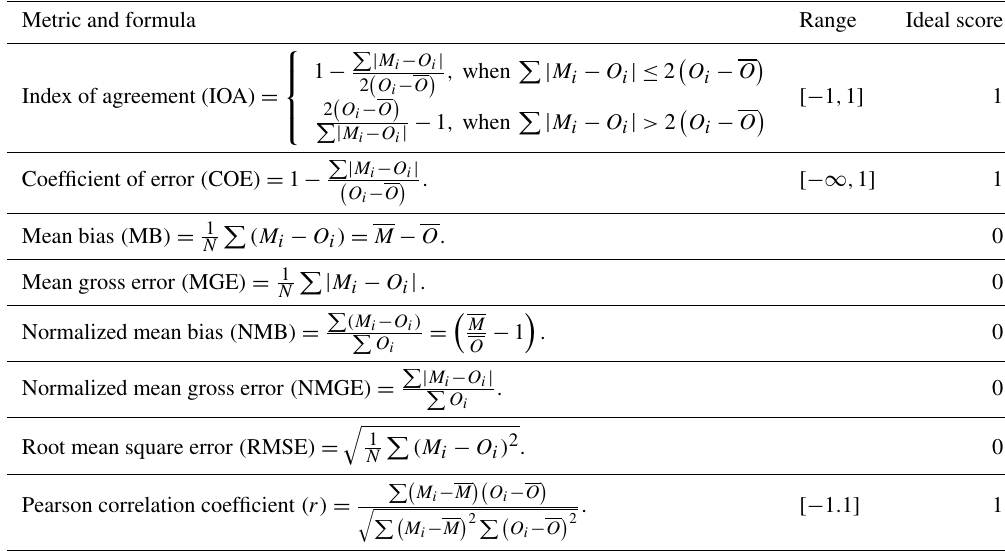
Table A1. Model comparison statistics.